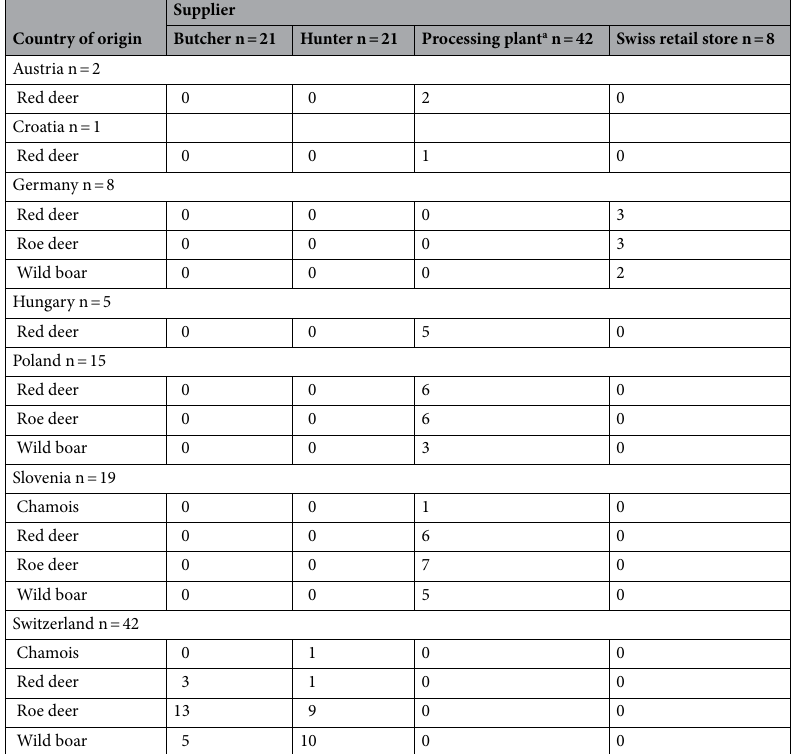
Table 3. Origin of 92 wild game meat samples from several European countries and from different suppliers. a The game meat processing plant is located in